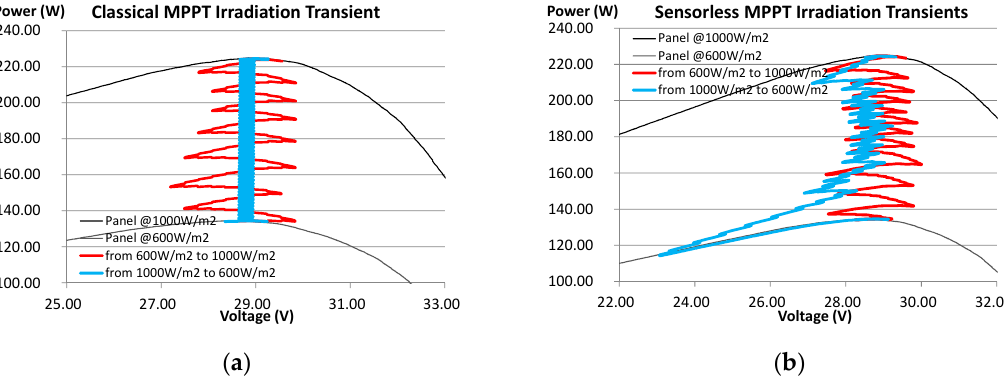
Figure 19. Irradiation transients test. Total time: 50 s. F MPPT = 10 Hz. ( a ) Conventional, V PV step: ∆ V PV_Re